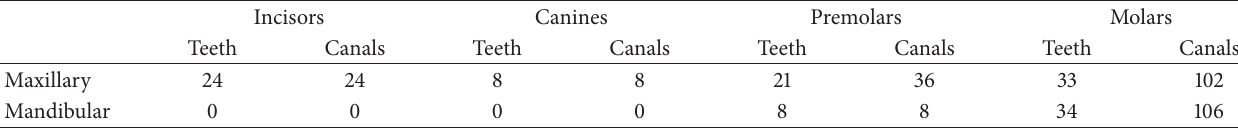
Table 1: Distribution of teeth and root canals in both jaws.